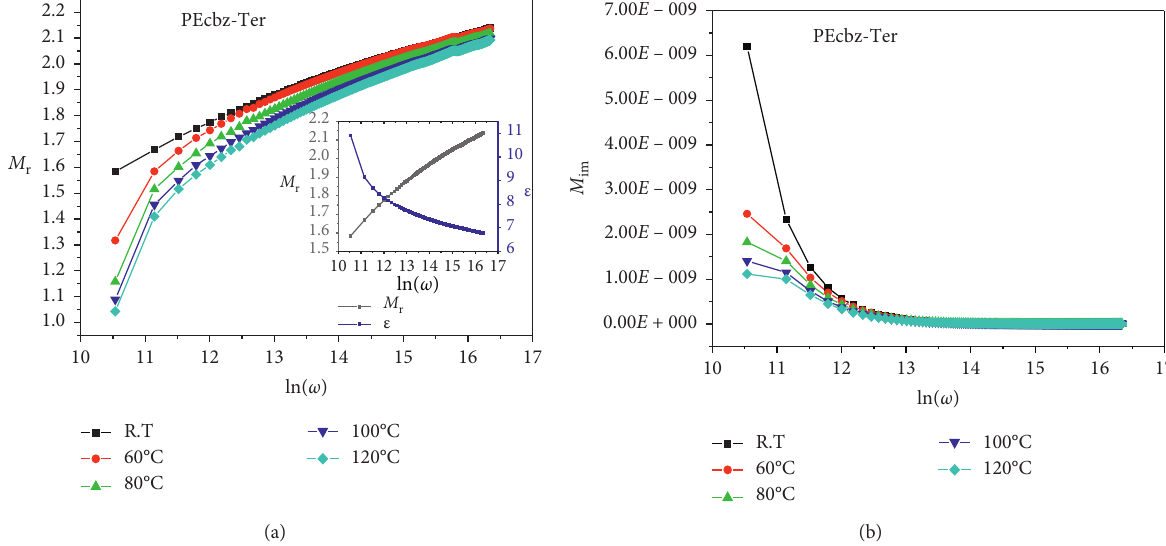
Figure 7: (a) Real electrical modulus vs. frequency of PEcbz-Ter at different temperatures. (b) Imaginary electrical modulus vs. frequency of PEcbz-Ter at different